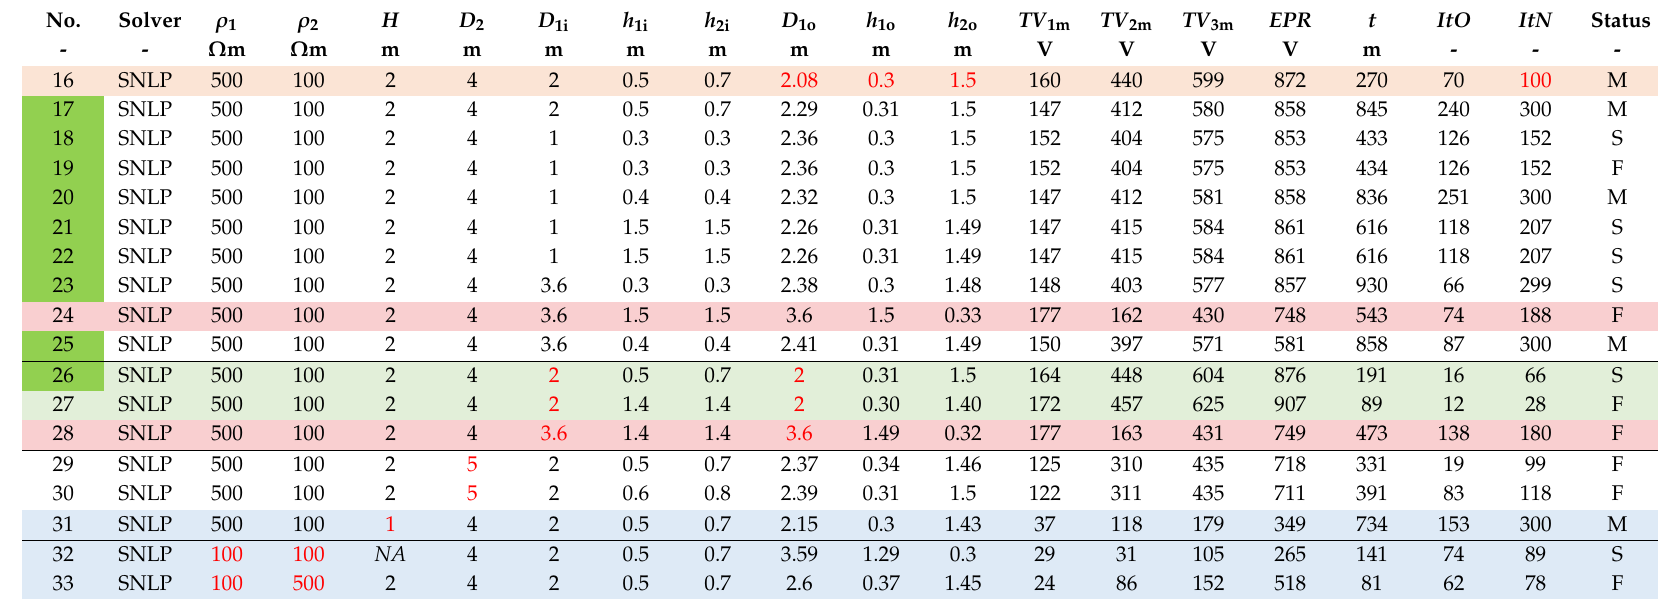
* In case of Uniform soil model the surface layer thickness is inappropriate so denoted in the table as NA—not available. * * Significant values defining optimisation, e.g., D 1 not optimised, increased D 2 = 5 m, di ff erent soil model — red text . * Optimisation ended in local minimum— light red , * Global optimum reached— dark green . * Only burial depths optimised— light green , * Iteration limit set to 100 only— light orange . * Uniform and LoH soil models— light blue